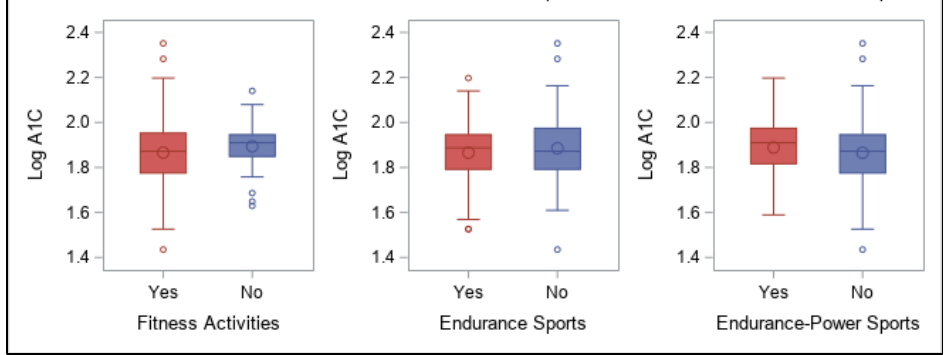
Figure 6. Participation in fitness activities, endurance sports, and endurance-power sports and association with log A1C values.